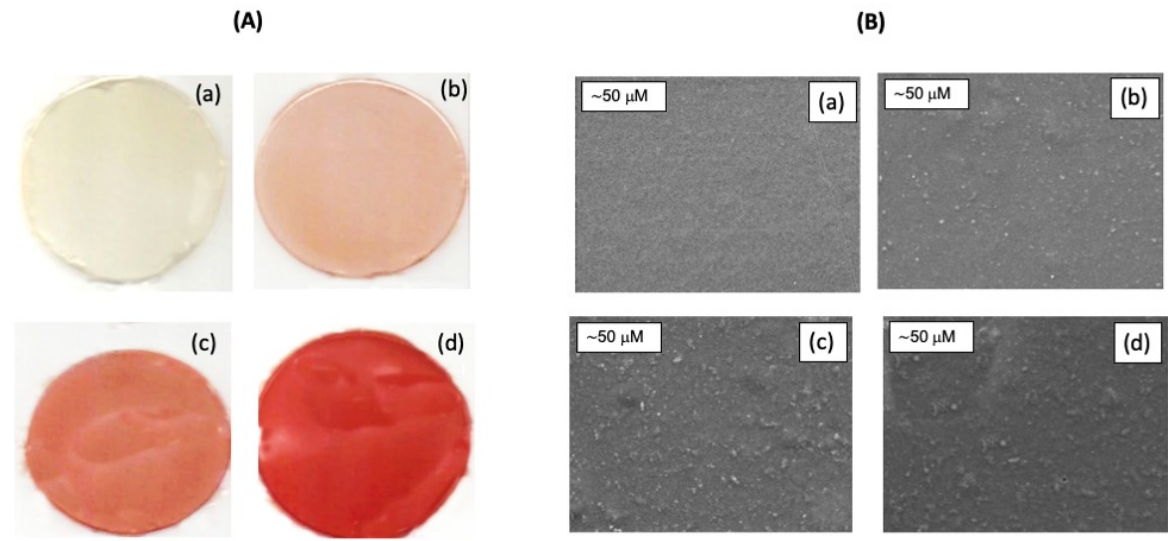
Table 1. Color properties 1 of chitosan (CH) with squid gelatin hydrolysate (SGH) films. Parameter